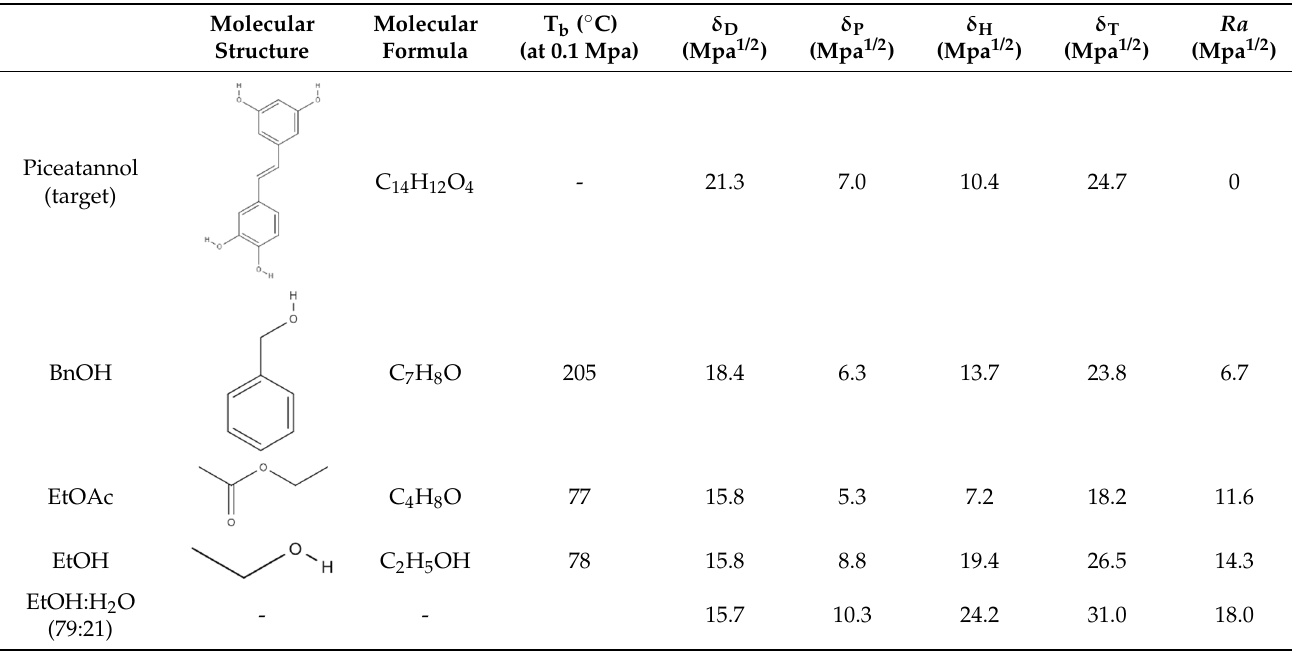
Table 1. HSP * values, temperature of the boiling point (T b ), and relative energy distance ( Ra ) between target compound